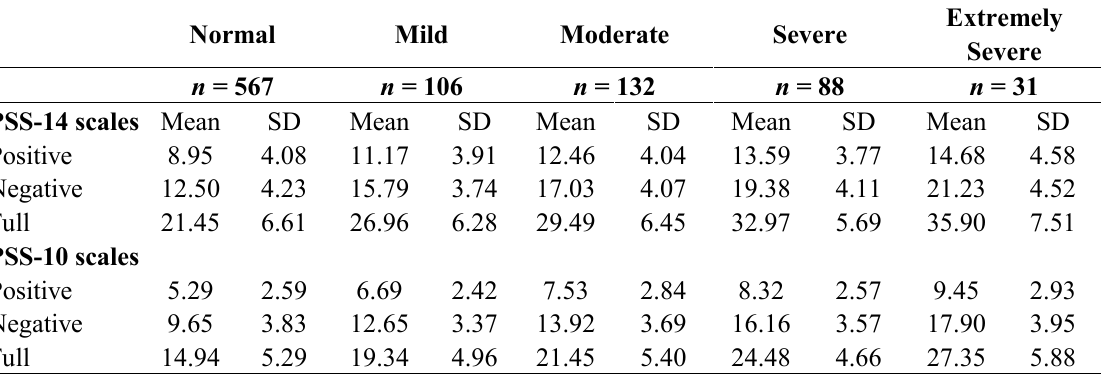
Table 5. Overall and subscales scores of PSS-14 and PSS-10 by the level of stress according DASS21 stress